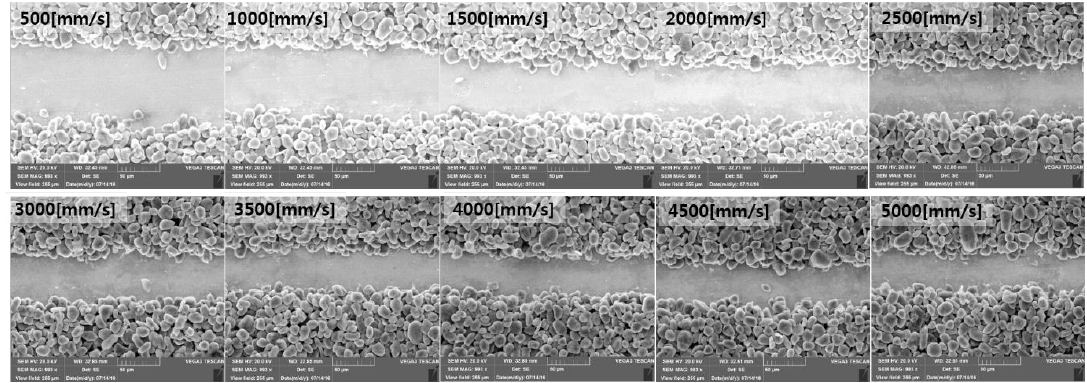
Figure 12. SEM images with a laser power of 50 W.